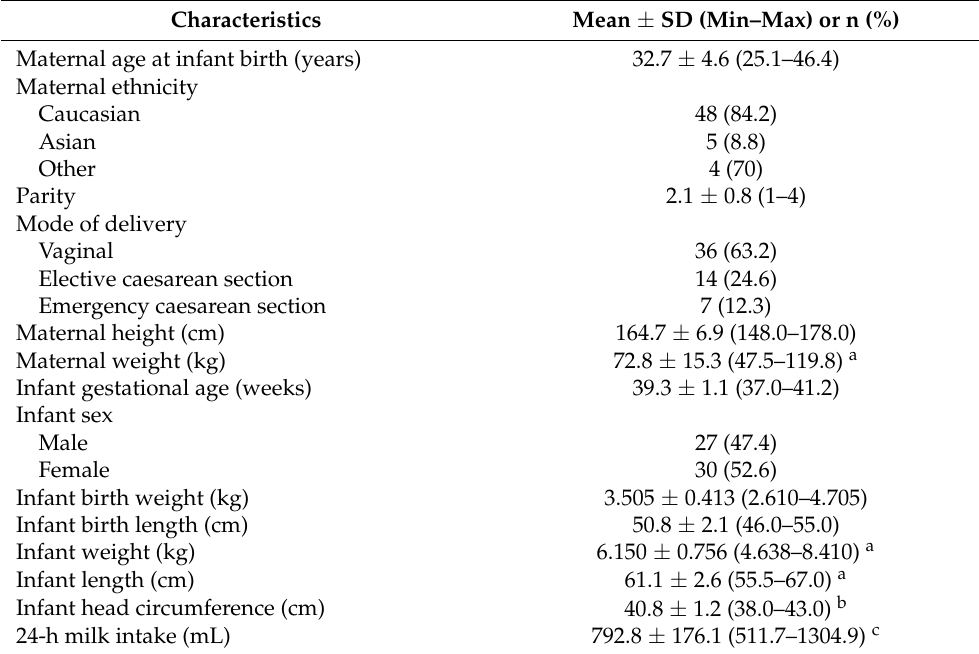
Table 1. Maternal and infant